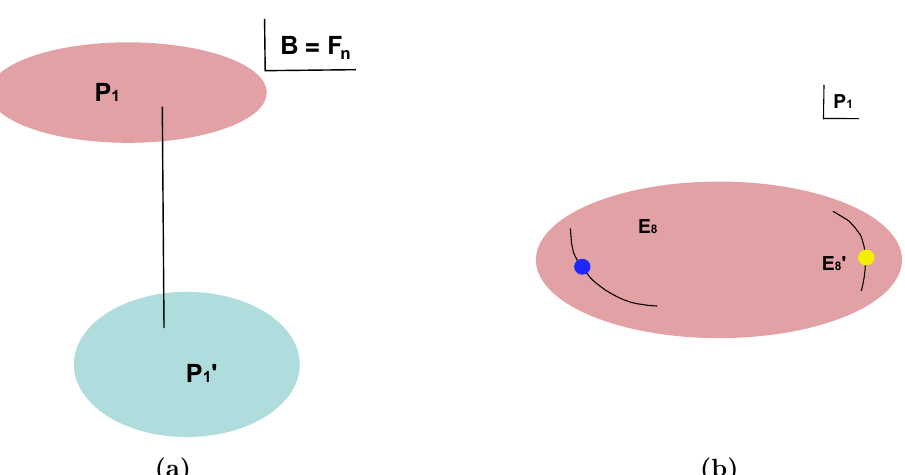
Figure 2. (a) The Herzebruch surface F n of the base B . (b) Loci of seven branes for E 8 (cid:2) E 8 gauge